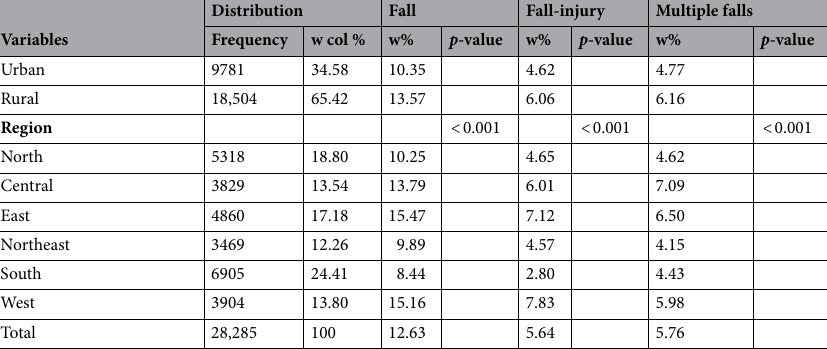
Table 1. Sample distribution and rates of fall, fall-injury and multiple falls by background characteristics among older adults. Notes: w col %: Weighted column percentage; w%: weighted percentage prevalence to account for survey design and provide national population estimates; ADL: Activities of daily living; IADL: Instrumental activities of daily living; MPCE: Monthly per capita consumption